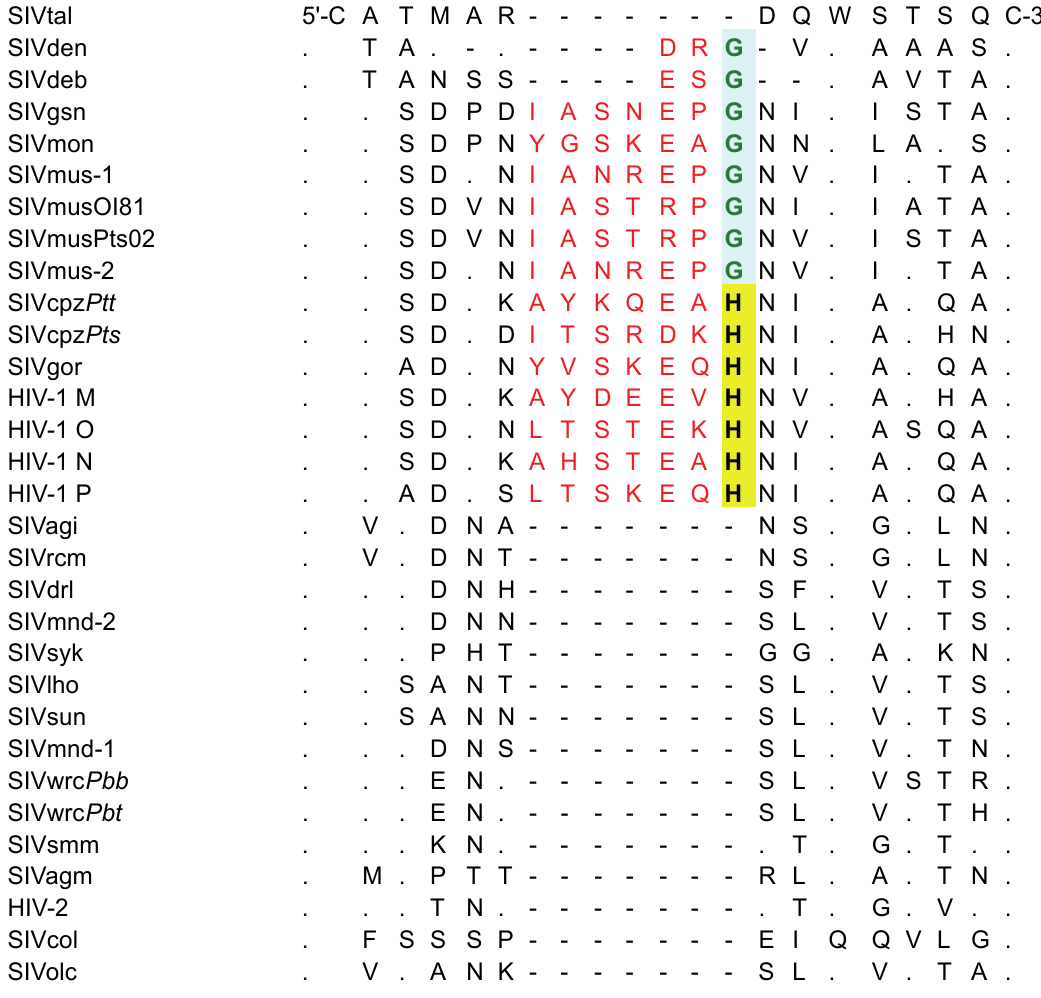
Figure 2. Comparison of C1 domain, between the first and second conserved cysteine residues for different Simian Immunodeficiency Virus (SIV) lineages, Human Immunodeficiency Virus (HIV)-1 and HIV-2. The insertion of seven amino acids present in the SIVmus/mon/gsn lineage, SIVcpz, SIVgor and HIV-1 M, N, O, P is shown in red letters. In SIVs from guenons ( Cercopithecus species), this domains ends in a glycine (highlighted in green box), while in all hominoid lineages the last amino acid residue of this domain is a highly conserved histidine (highlighted in yellow box). Dots indicate amino acid identity and dashes indicate gaps introduced to optimize the alignment. SIVtal